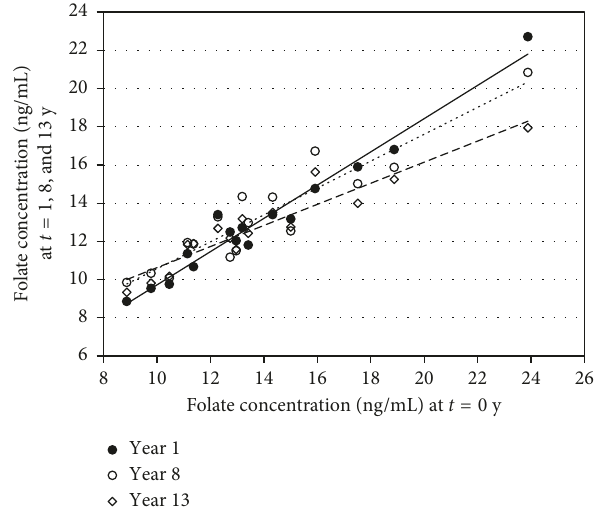
Figure 3: Correlation between the mean folate concentrations at t � 0 and after storage for 1, 8, and 13 years at − 70 ° C. The cor- relation lines have the following equations: y � 0.870 x +1.02 , y � 0.703 x +3.53 , and y � 0.552 x +5.11 for 1, 8, and 13years,